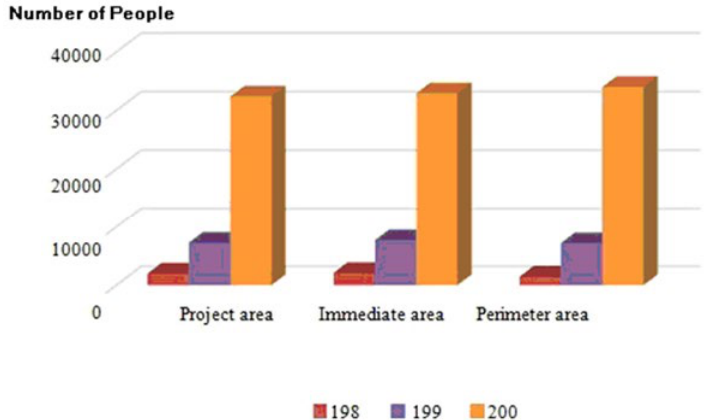
Fig. 2: The demographic changes of the study area during the years 1978 to 2007 ( Momeni et al., 2016 ) Table 1: Uses’ levels before and after implementation within the project area